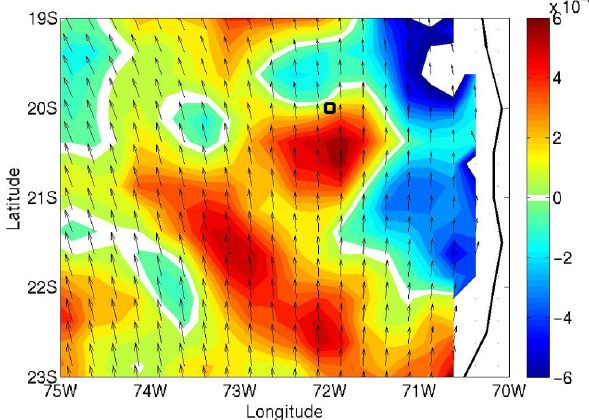
Fig. 3. The average surface wind (vectors) and divergence (color shading, increment=2 × 10 − 6 s − 1 ) from QuikSCAT (16 October– 13 November 2008). Point Alpha is marked as the blue square